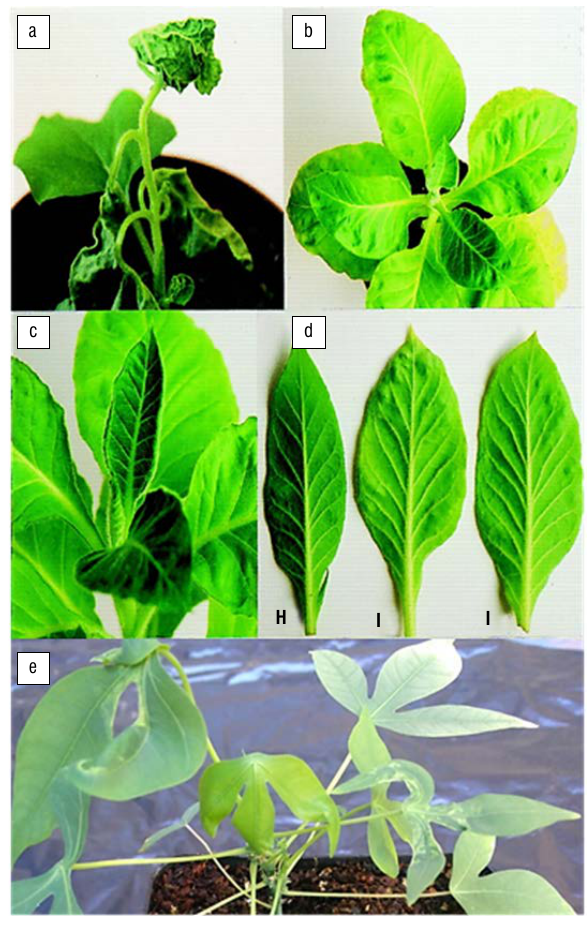
Figure 2: Symptoms seen on tobacco following agro-inoculation with monopartite Tobacco leaf curl Zimbabwe virus DNA A. (a) Nicotiana benthamiana (100% infection 2 weeks post- inoculation) exhibiting stunting, severe upward leaf curling, leaf distortion, ventral vein thickening and bending of petioles. (b) N. tabacum cv. Samsun (100% infection 4 weeks post- inoculation), showing extensive puckering of dorsal leaf surfaces. (c) N. tabacum cv. Samsun showing leaf margins of newly developing leaves curling upwards. (d) N. tabacum cv. Samsun ventral leaf surfaces of healthy (H) and infected (I) plants, showing vein thickenings present on smaller veins of the infected plants that are absent in the healthy plants (source: Paximadis and Rey 50 ). (e) Symptoms of leaf curl and mosaic on cassava cv.60444 agro-inoculated with bipartite South African cassava mosaic virus DNA A and